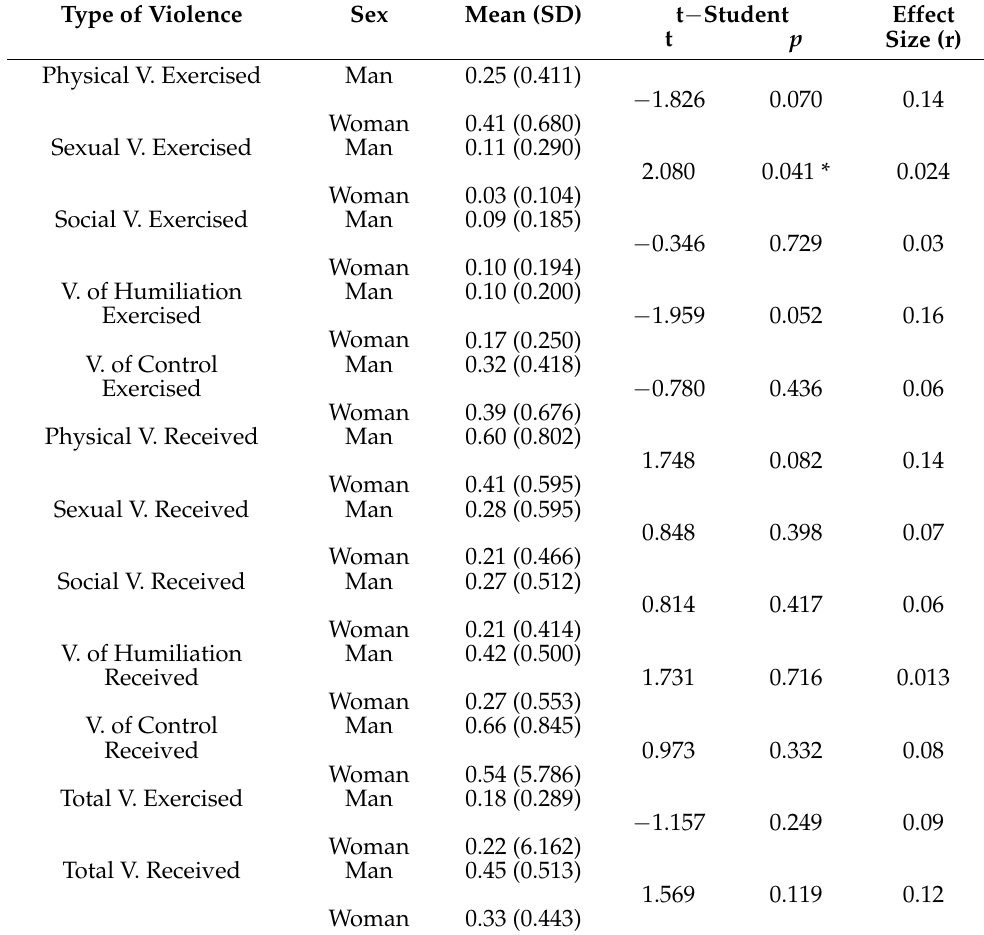
Table 4. Differences in Violence Exercised and Received according to